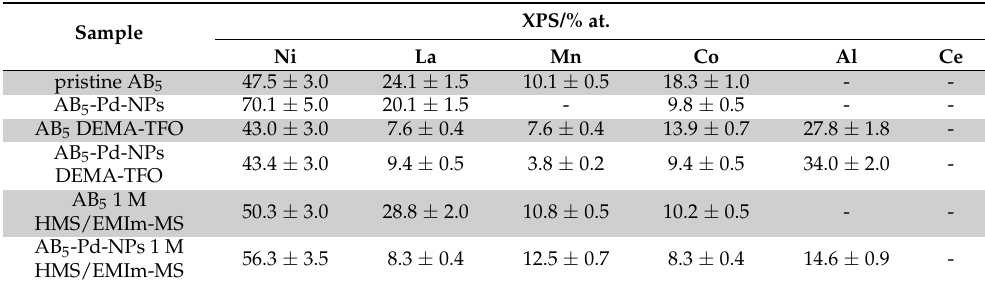
Table 4. Surface atomic concentrations (XPS) of selected elements for AB 5 and AB 5 -Pd-NPs electrodes before and after electrochemical treatment in DEMA-TFO and 1 M HMS/EMIm-MS. XPS/% Sample